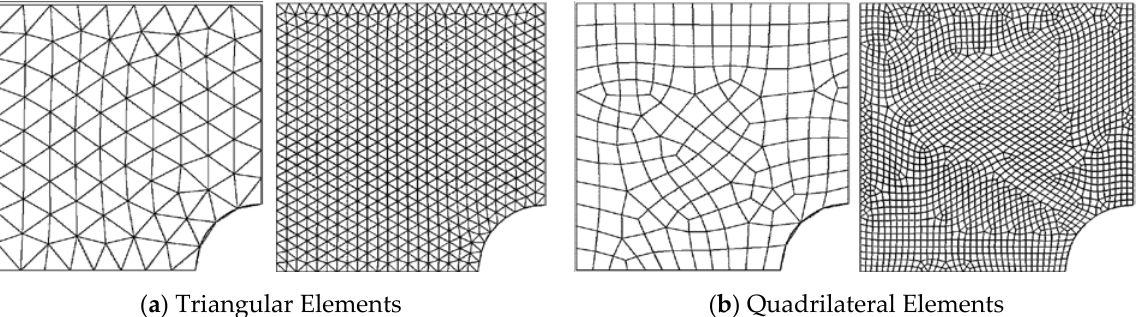
Figure 5. Triangular/quadrilateral elements mesh for plate with opening domain.